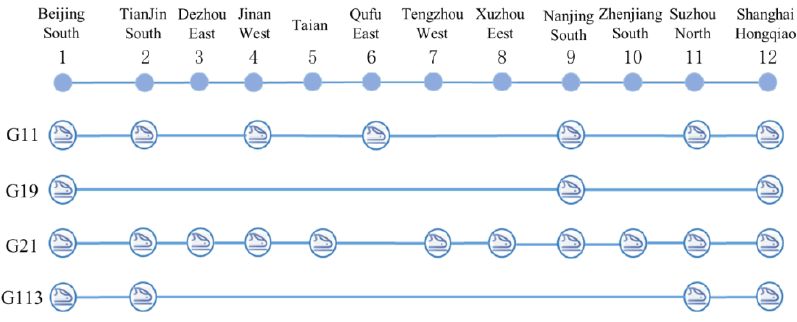
Figure 7. The optimized train stop plan.